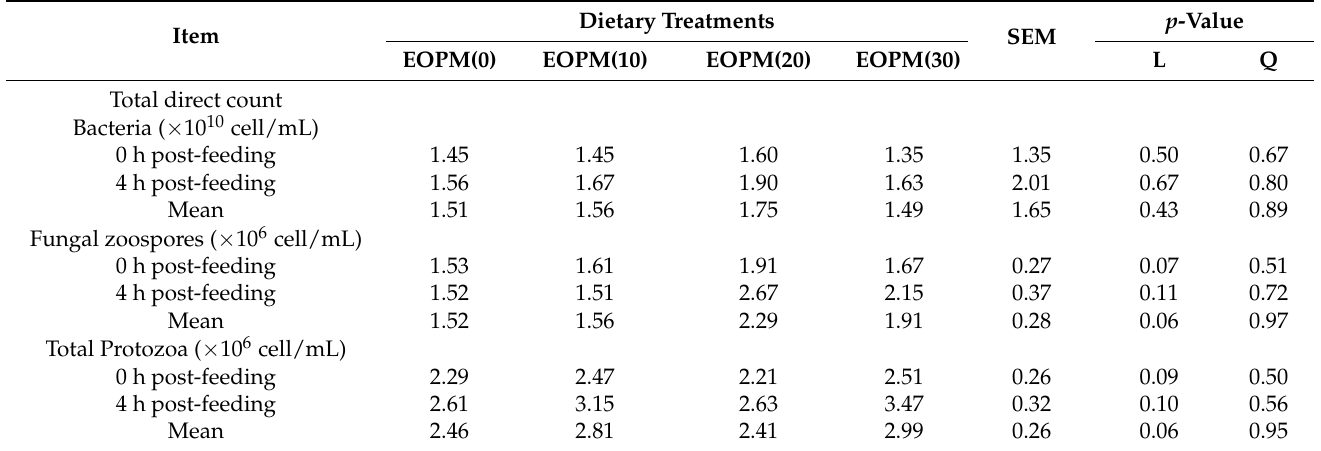
Table 7. Rumen microbes in goats fed TMR diets containing extracted oil palm meal